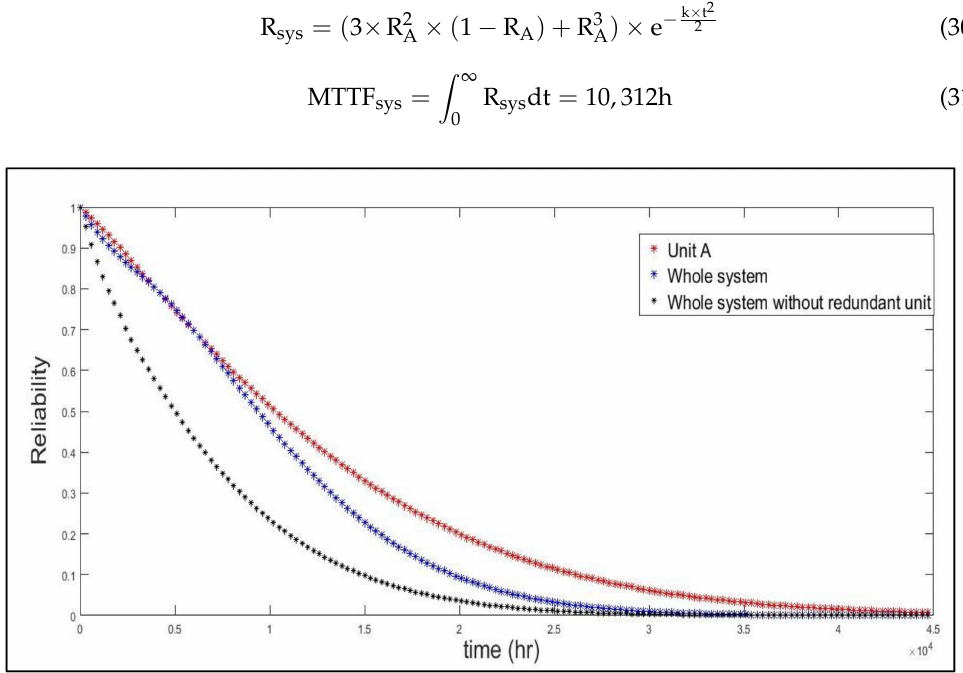
Figure 7. Reliability profile of the complete system, unit A and the system without redundant